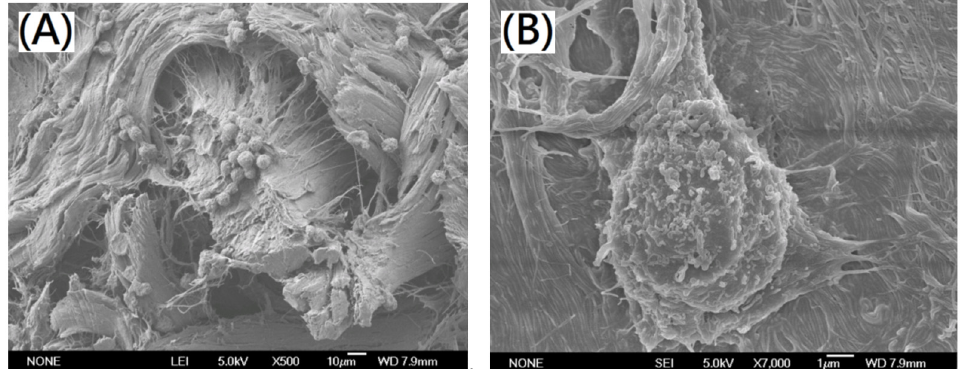
Figure 9. SEM photographs of L929 cells grew on the resulting decellularized nano-bioscaffold microparticle with magnification ( A ) 500 × (scale bar indicates 10 μ m) ( B ) 7000 × (scale bar indicates 1 μ m).